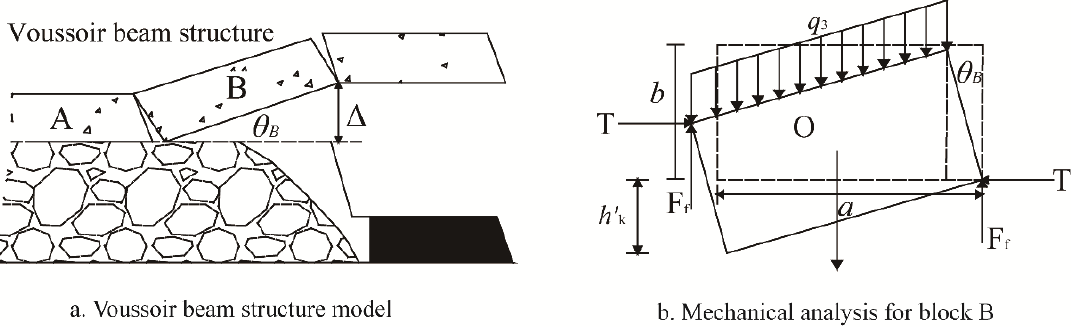
Figure 10. Voussoir structure and mechanical analysis for block B.